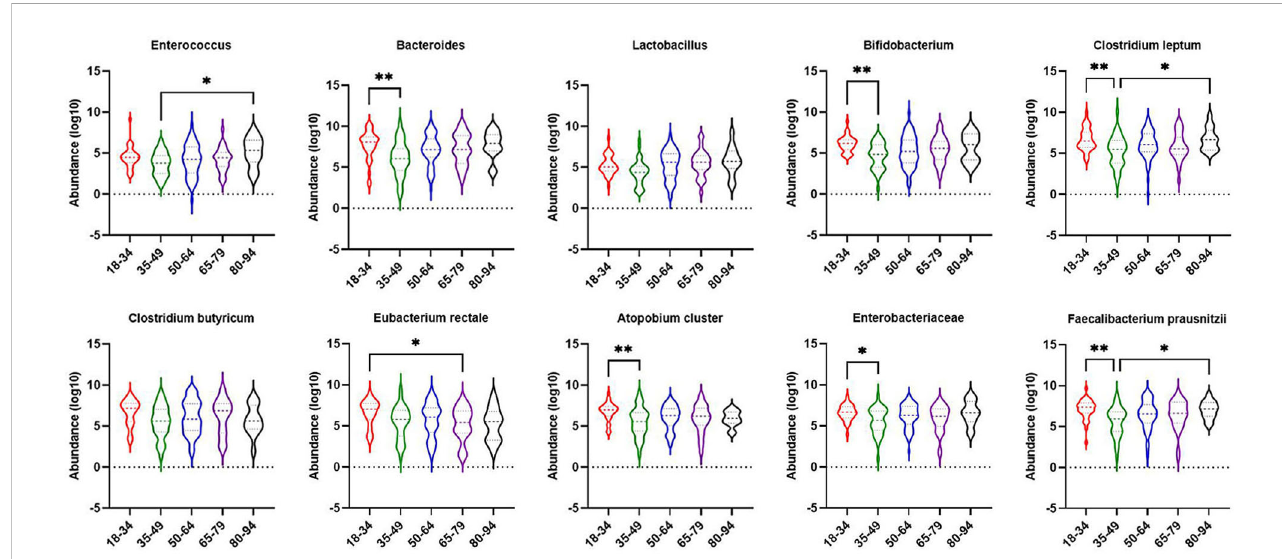
FIGURE 5 Comparison of dominant gut microbiota in different age groups of obesity with NAFLD and simple obesity populations. The symbol * represents p-value less than 0.05. And the symbol ** represents p-value less than